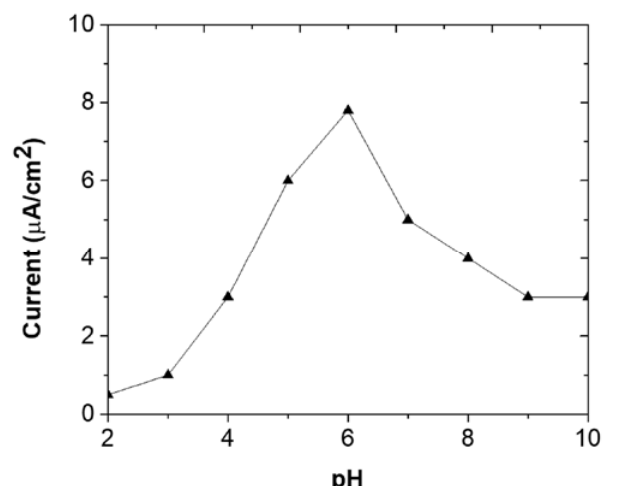
Fig. 7. Effect of pH on the electrochemical response of the Pd@MWCNTs/GCE. The concentration of butachlor is 6.0 μg ⸳ mL −1 ; accu- mulation potential –1.13 V; accumulation time 80 s; pulse amplitude 30 mV; scan rate 50 mV s -1